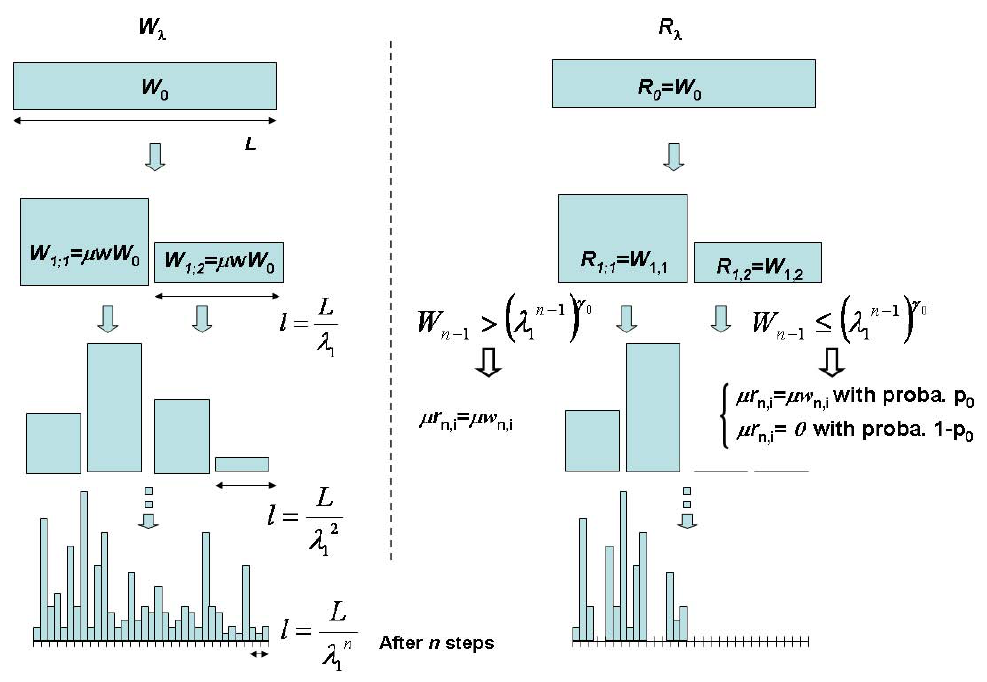
Fig. 1. Illustration of the cascade processes to generate W λ and R λ